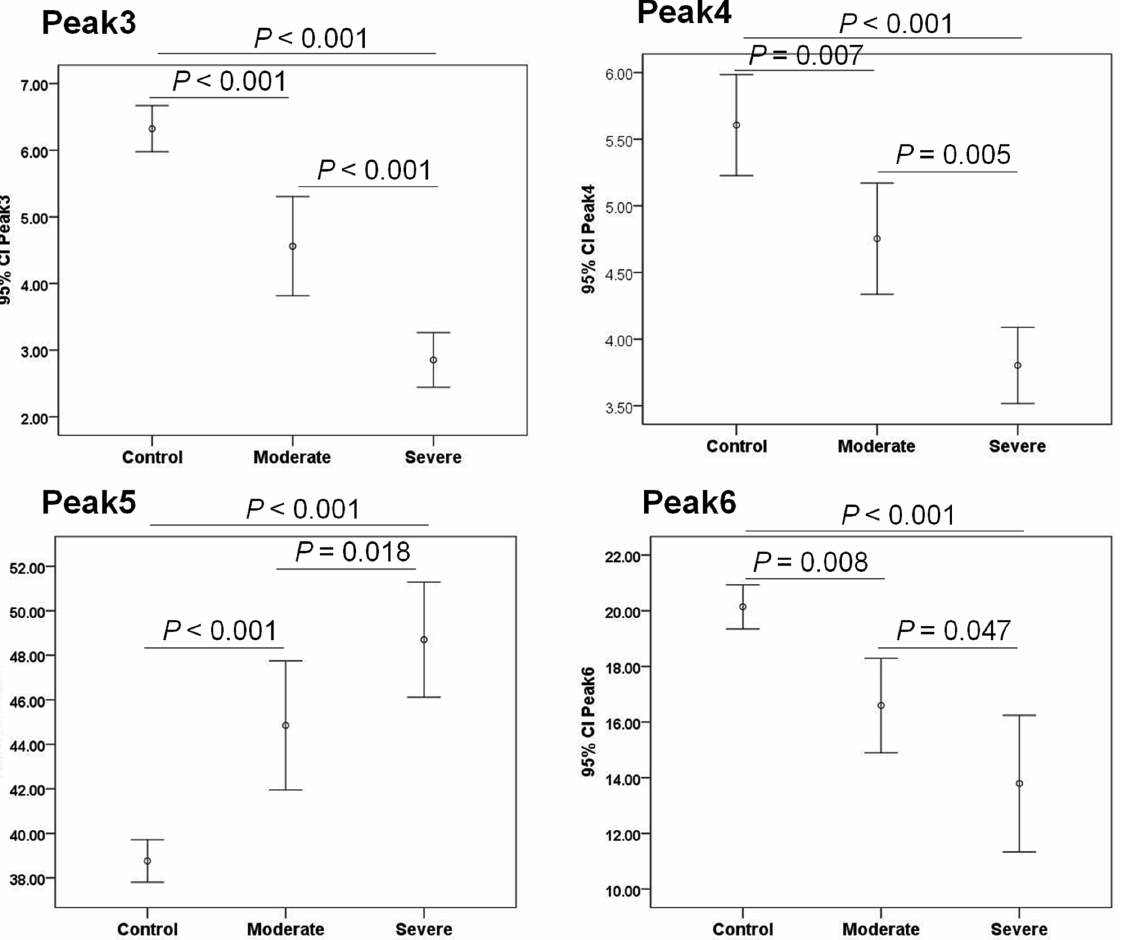
Fig 2. Peak abundances for the N-glycans which had the obvious overall changes among control subjects, moderate and severe LCMM subjects. Peak3, Peak4 and Peak6 decreased, whereas Peak5 increased associated with the severity of LCMM disease. Error bars are 95% confidence interval (95% CI) of the